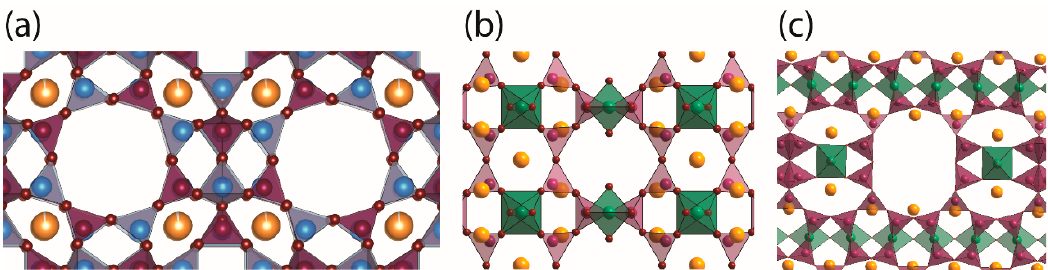
Figure 1. Representation of the pore structure of the materials. ( a ) Zeolite 4A structure with eight-ring pore opening of about 0.4 nm composed of Al (blue) and Si (purple) tetrahedra connected by O, ( b ) ETS-4 structure with eight-ring pore opening of about 0.4 nm composed by Si (purple) tetrahedra and Ti (green) octahedra (one oxygen on the vertical octahedra corresponds to water that can be removed to obtain pentacoordinated Ti) and ( c ) ETS-10 structure with 12-ring pore opening of about 0.8 nm composed by Si (purple) tetrahedra and Ti (green) octahedra. In the case of Co-ETS-4 the extra-framework cations were replaced by Co and in the case of ETAS-10 some Si was replaced by Al, but the structure is analogous to ETS-10. Colour code: Si purple, Ti green, Al blue, O red and cations in yellow. Note: materials labelled ETS are types of titanosilicates.